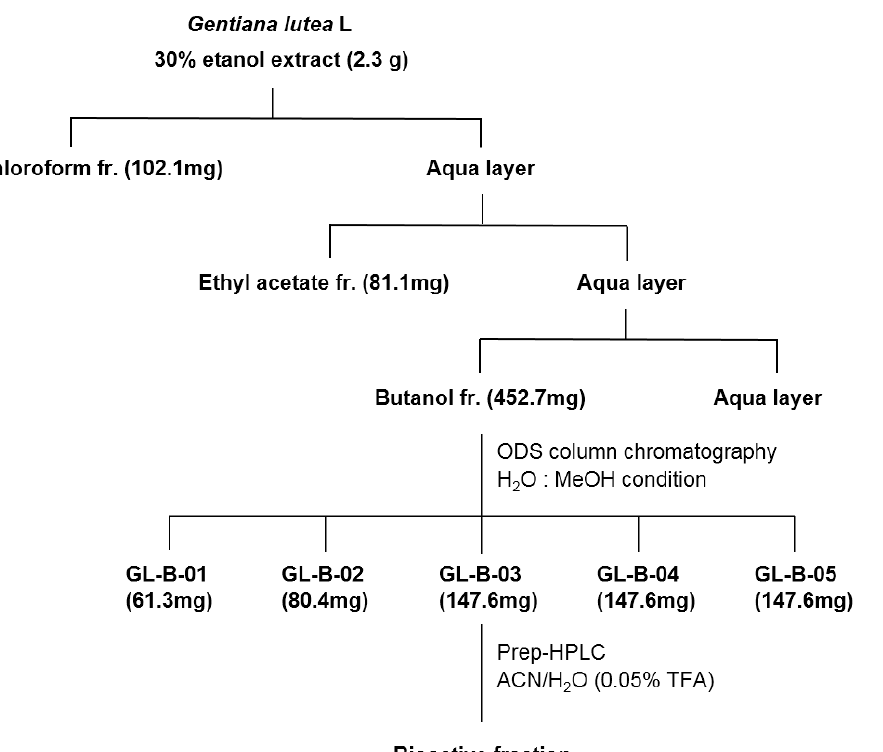
Figure 1. Extraction and fractionation of bioactive components from a 30% ethanol extract of Gentiana